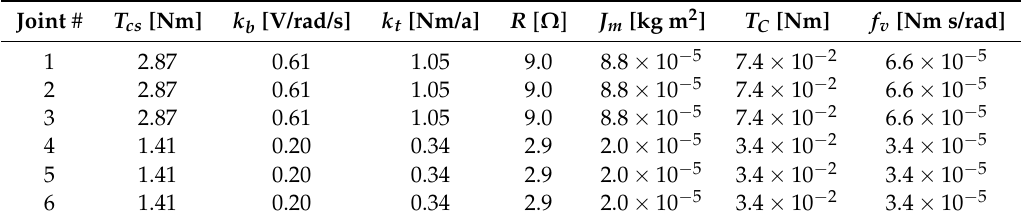
Table 3. Estimated motor